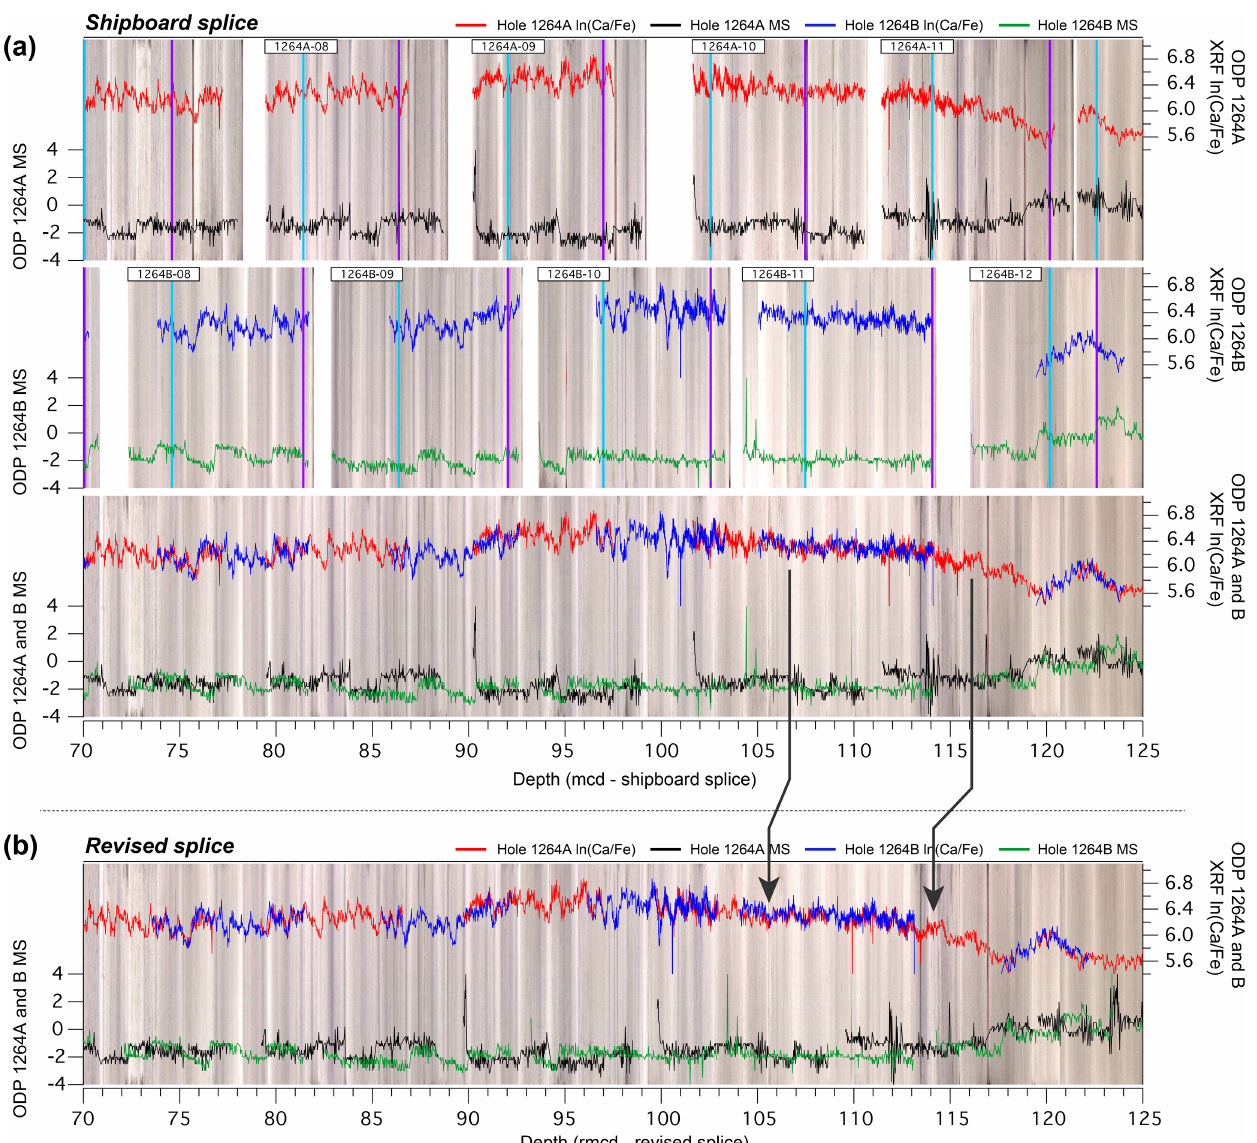
Figure 2. Overview of main splice change between the shipboard splice (a) and the revised splice presented in this study (b) . The interval between arrows on the splice was revised based on the ln(Ca / Fe) data. The shipboard magnetic susceptibility (MS) is too low amplitude in the late Miocene in particular to robustly revise the splice, whereas ln(Ca / Fe) data showed the sedimentary variability well. In certain high CaCO 3 intervals Ba counts were also used to revise the composite splice (Fig. S3). The individual holes are shown for the shipboard splice only, with splice intervals shown between consecutive turquoise (top) and purple (bottom) vertical